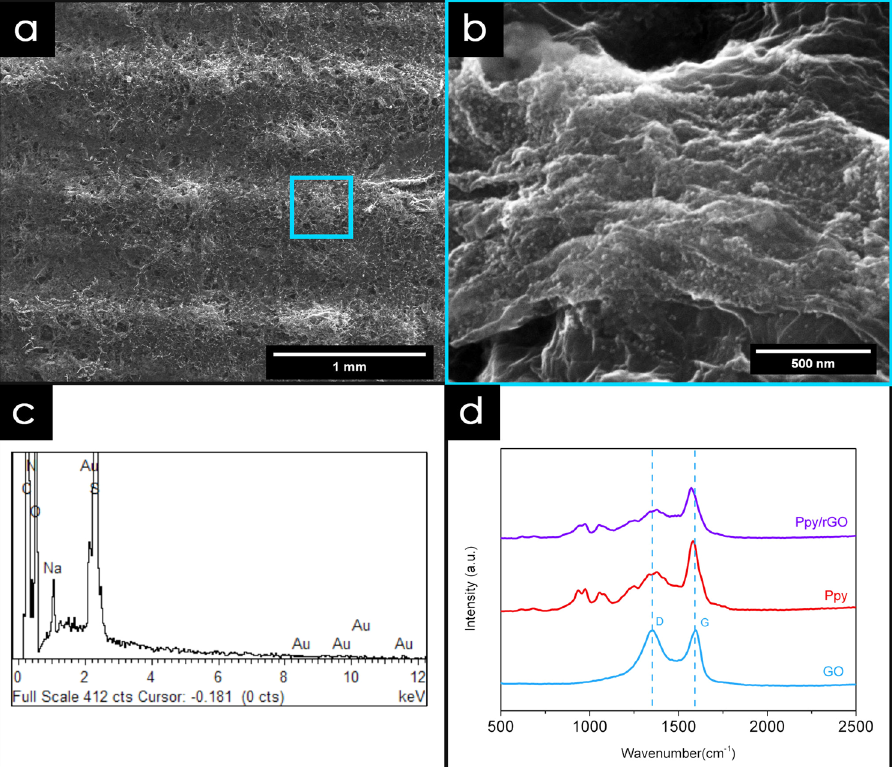
Figure 2. FESEM image of ( a ) Ppy/rGO nanocomposite on the electrode surface and ( b ) its corresponding magnified image. Corresponding ( c ) EDX and ( d ) Raman analysis of Ppy/rGO